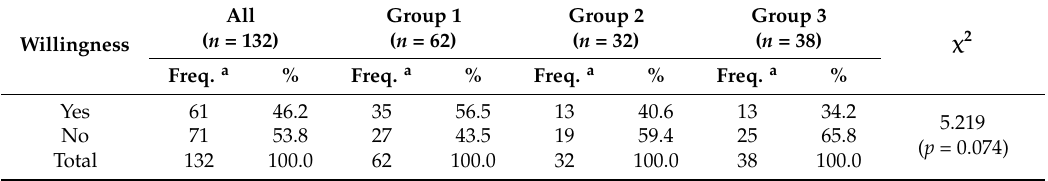
Table 6. Difference of willingness to invest in FCO projects among sample